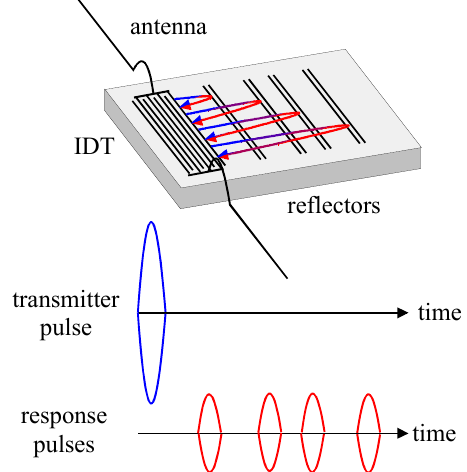
Figure 1. RFID-Tag with interrogation and response signals.